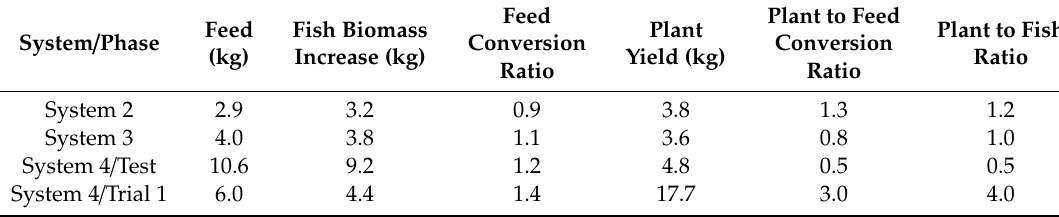
Table 6. Harvest results from the systems. Plants grown in Systems 2 and 3 were mixed herbs and leafy greens, whereas in System 4 pak-choi was grown as a single crop (see Table 2). Feed Plant to Feed Feed Fish Biomass Plant Plant to Fish System / Phase Conversion Conversion (kg) Increase (kg) Yield (kg) Ratio Ratio Ratio System 2 2.9 System 3 System 4 / Test 10.6